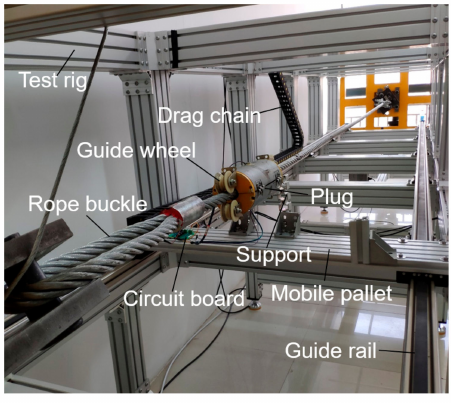
Figure 16. Test rig.